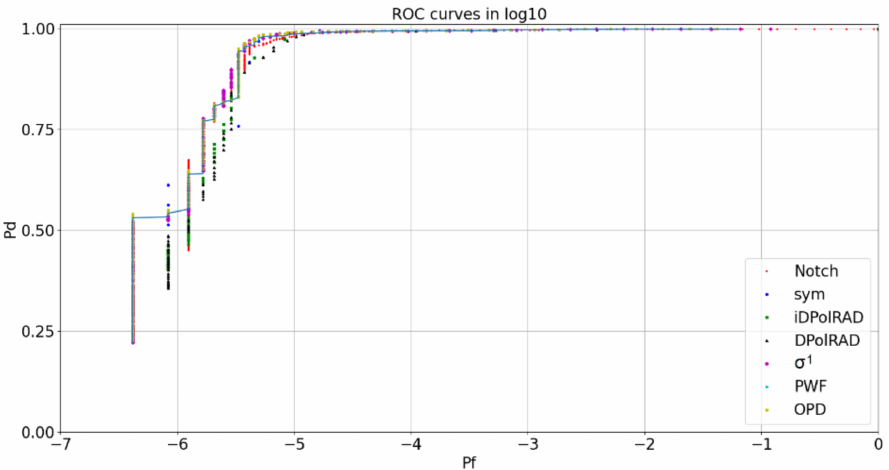
Figure 17. Iceberg detection dual-polarimetric ROC curves for open ocean, 5 × 5, clutter window size 105 × 105. Sym means symmetry detector. iDPolRAD and DPolRAD mean intensity dual-polarisation ratio anomaly detector, and σ 1 is from the polarimetric match